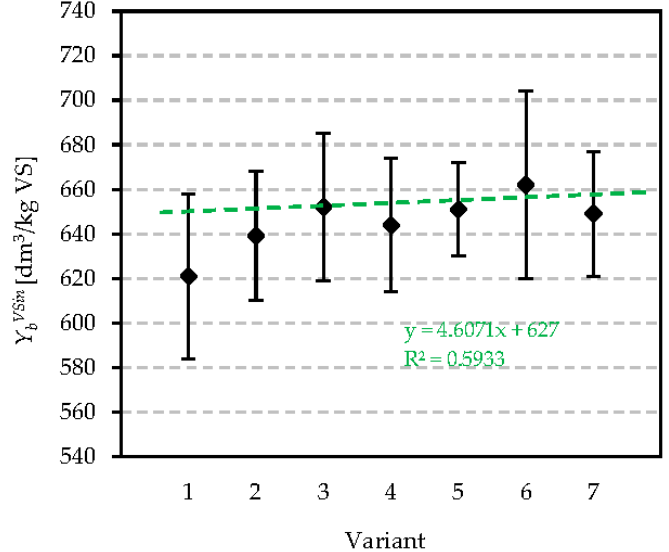
Figure 2. One-time biogas production efficiency.